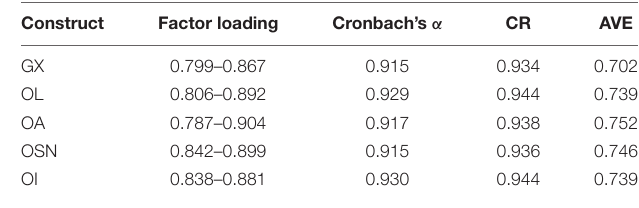
TABLE 2 | Descriptive statistical analysis.